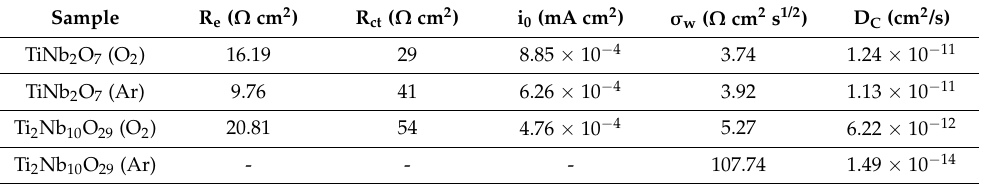
Table 3. EIS parameters of the produced